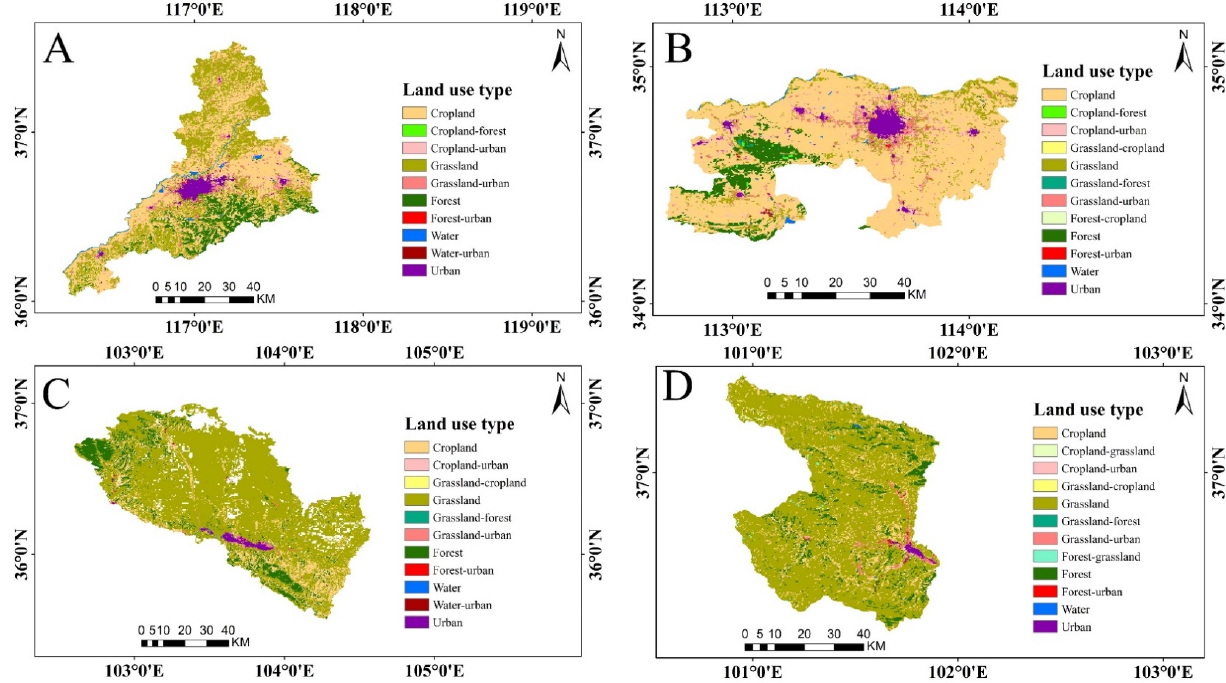
Figure 3. Spatial distribution of land use types in Jinan, Zhengzhou, Lanzhou and Xining in 2015. Connectors indicate the transfer of land types from 2000 to 2015. For example, Cropland-urban indicates that cropland areas have turned into urban areas. (( A ) Jinan City, ( B ): Zhengzhou City, ( C ): Lanzhou City, ( D ): Xining City). Table 2. Statistical table of land type change and proportion in four cities.